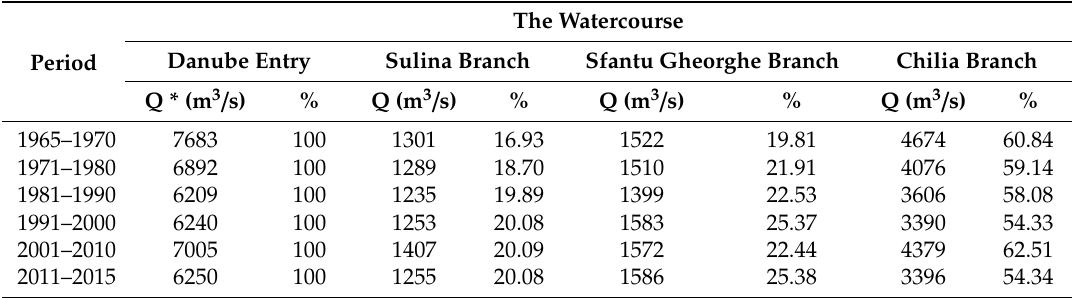
Table 1. Average flows of the Danube at intervals of 5, 6, and 10 years, respectively, at the entrance to the Delta and on the three main branches (between 1965–2015).